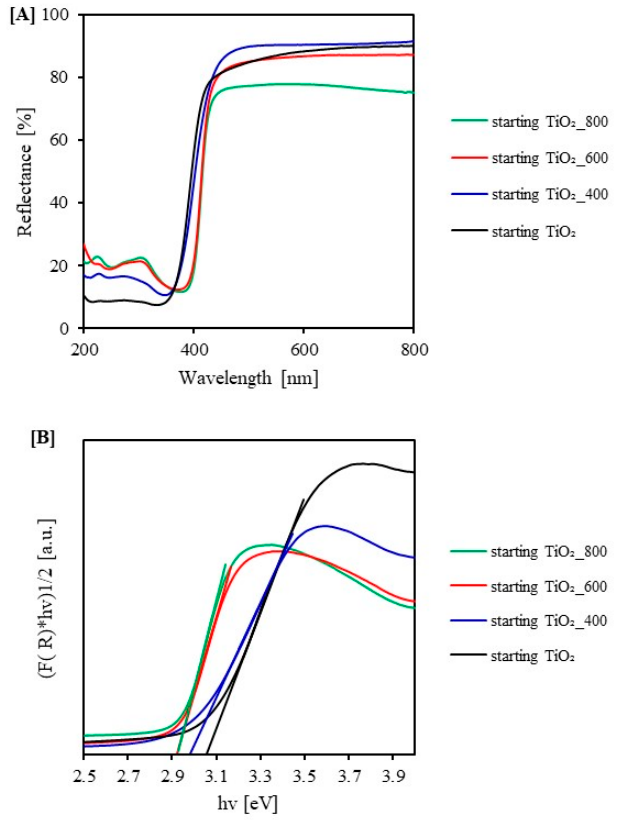
Figure 4. UV-Vis/DR spectra ( A ) and Tauc plot ( B ) of starting TiO 2 and reference materials.